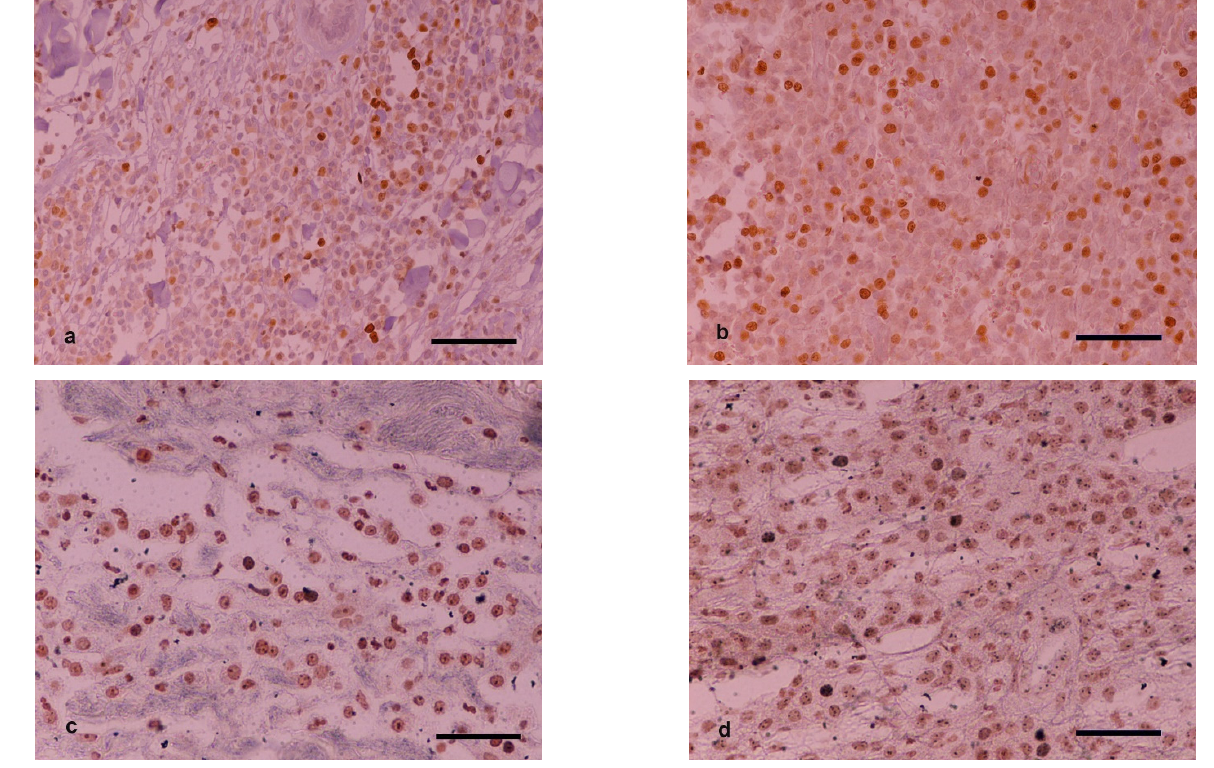
Figure 2. Ki-67 immunohistochemical staining, DAB chromogen, H&E counterstain ( a , b ). ( a ) MCT with low Ki-67 scoring ( b ) MCT with high Ki-67 scoring. Histochemical staining for argyrophilic nucleolar organizing region (AgNOR) ( c , d ). ( c ) MCT with low AgNOR scoring ( d ) MCT with high AgNOR scoring. Scale bar: 50 µ